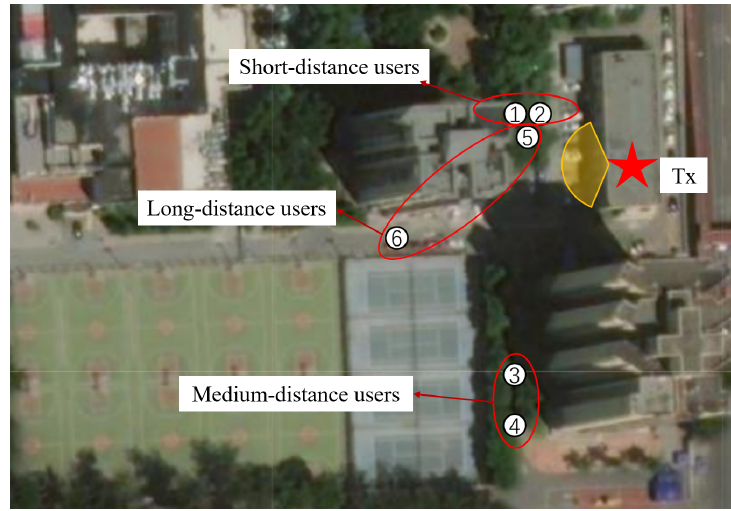
Figure 10. The top view of a practical urban micro measurement scenario from Baidu satellite map.